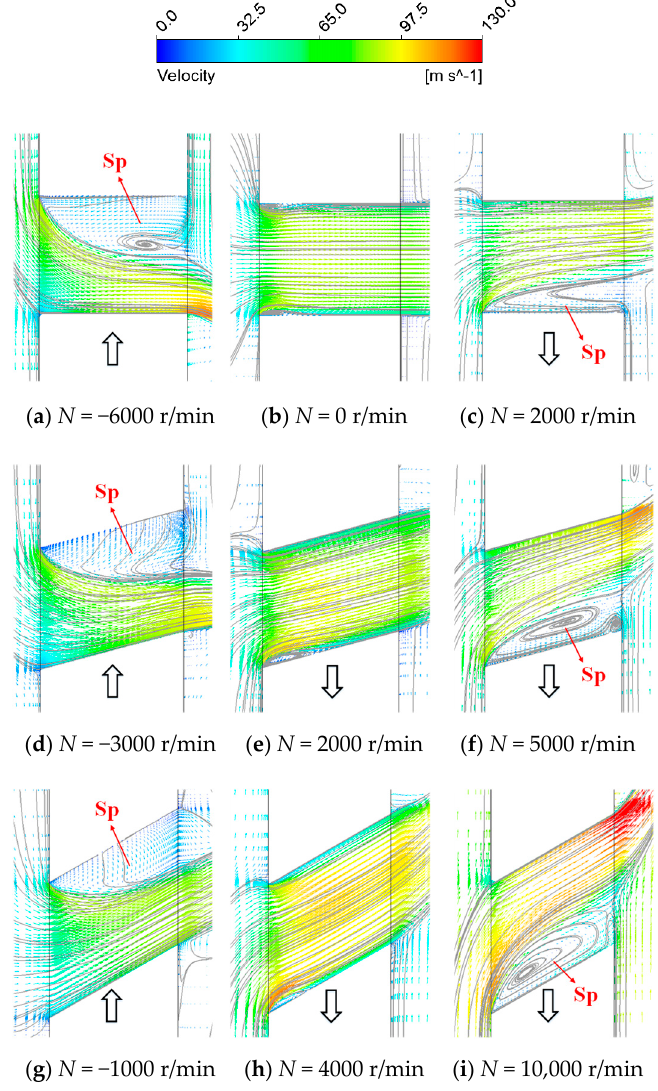
Figure 17. Schematic diagrams of streamlines and velocity vectors. ( a ) 𝛽 (cid:2868) = 0°, i = − 35.7°, 𝐶 d = 0.378, ( b ) 𝛽 (cid:2868) = 0°, i = 0°, 𝐶 d = 0.743; ( c ) 𝛽 (cid:2868) = 0°, i = 14°, 𝐶 d = 0.632, ( d ) = 15°, i = − 35.3°, 𝐶 d = 0.510, ( e ) ( b ) β 0 = 0 ◦ , i = 0 ◦ , C d = 0.743; ( c ) β 0 = 0 ◦ , i = 14 ◦ , C d = 0.632, ( d ) = 15 ◦ , i = − 35.3 ◦ , C d = 0.510, 𝛽 (cid:2868) = 15°, i = − 0.9°, 𝐶 𝛽 (cid:2868) = 15°, i = 16.4°, 𝐶 𝛽 (cid:2868) = 30°, i = − 37.1°, 𝐶 d = 0.765, ( f ) d = 0.502, ( g ) d = 0.639, ( h ) ( e ) β 0 = 15 ◦ , i = − 0.9 ◦ , C d = 0.765, ( f ) β 0 = 15 ◦ , i = 16.4 ◦ , C d = 0.502, ( g ) β 0 = 30 ◦ , i = − 37.1 ◦ , C d = 0.639, 𝛽 (cid:2868) = 30°, i = − 3.4°, 𝐶 𝛽 (cid:2868) = 30°, i = 18.4°, 𝐶 d = 0.805, ( i ) d = 0.371. ( h ) β 0 = 30 ◦ , i = − 3.4 ◦ , C d = 0.805, ( i ) β 0 = 30 ◦ , i = 18.4 ◦ , C d =